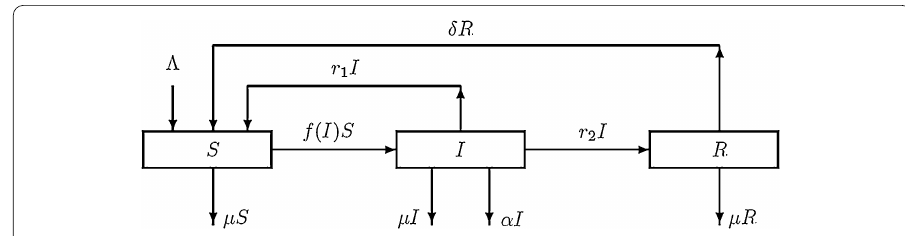
Figure 1 The process diagram for SIRS